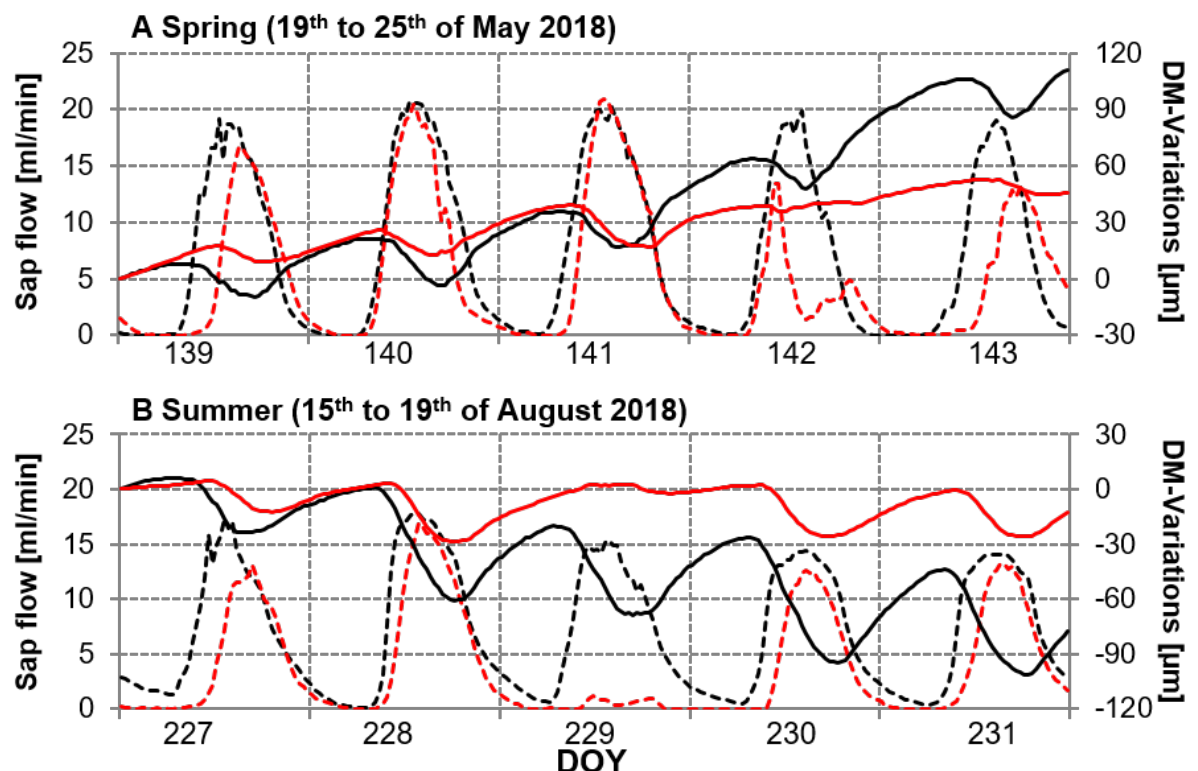
Figure 4. The mean diurnal cycles of the dendrometer (DM, solid lines) and sap flow (SF, dotted lines) data for both sites, EIF (red) and UWM (black) for 5 days in spring ( A ) and summer 2018 ( B ). For better illustration, the DM–data was set to zero on the first day of the example period.